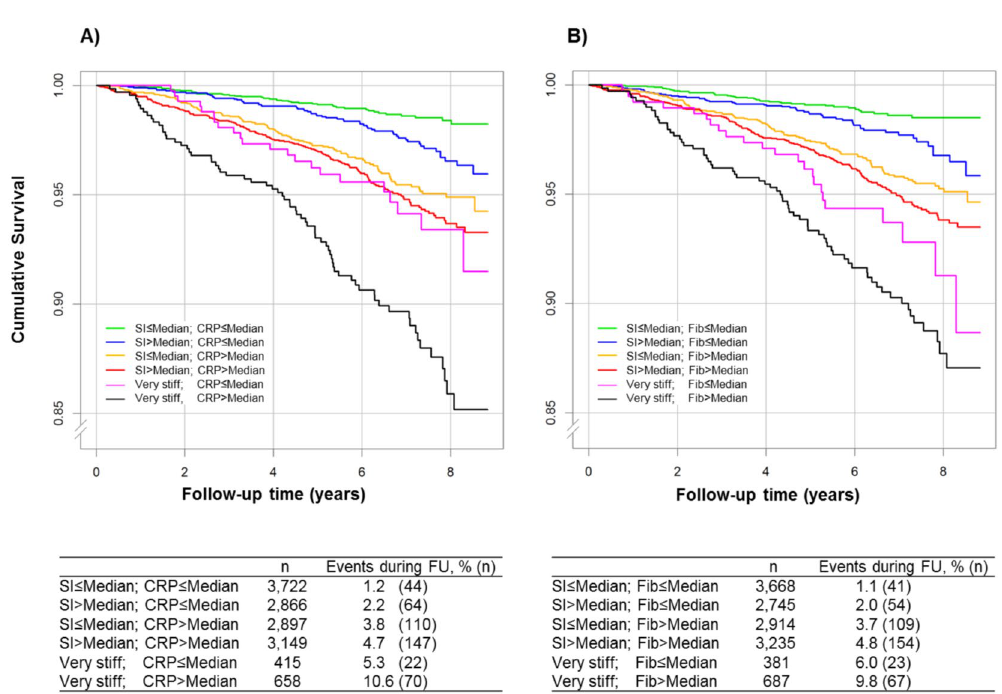
Figure 3. Effect of Arterial Stiffness and ( A ) C-reactive Protein or ( B ) Fibrinogen on Survival Over 8 Years. Panels display Kaplan-Meier Curves for a 8-year follow-up period according to arterial stiffness (with stiffness index below, equal and above the median, or very stiff), and CRP or fibrinogen below or equal and above the median concentration. SI stands for stiffness index, CRP for C-reactive protein and Fib for